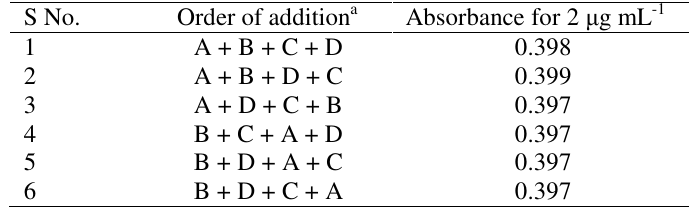
Table 2 . Optical parameters for the determination of